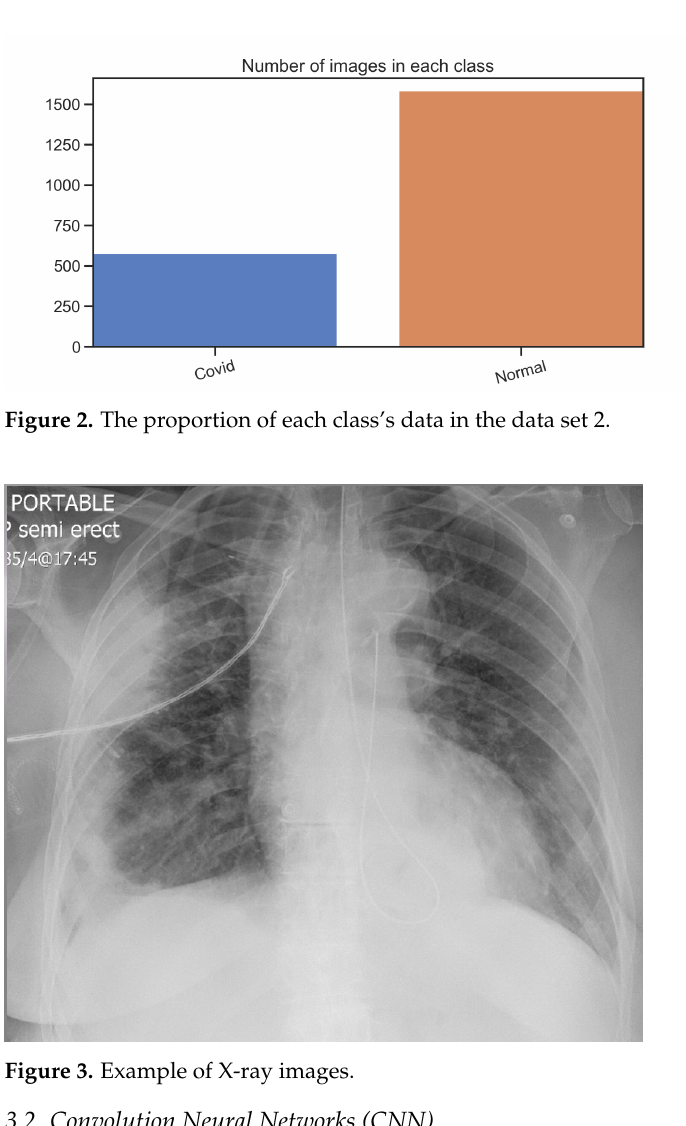
Figure 1. The proportion of each class’s data in the data set 1.